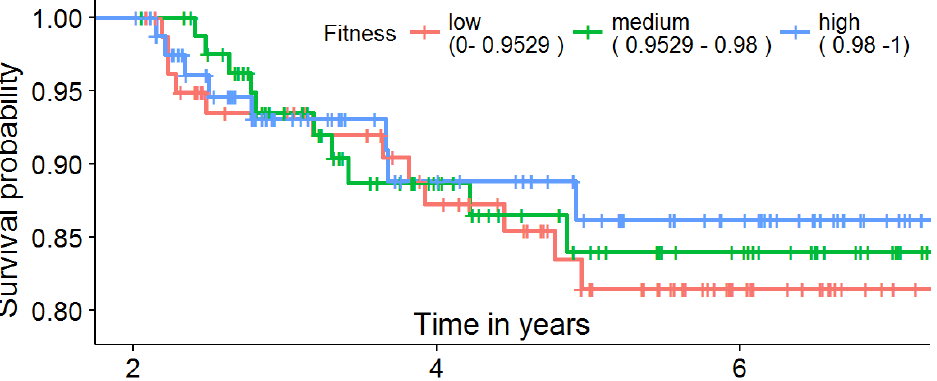
Figure 8. Survival analysis for all 246 patients that stayed in follow-up for more than two years, sampled into three equal-sized groups depending on their